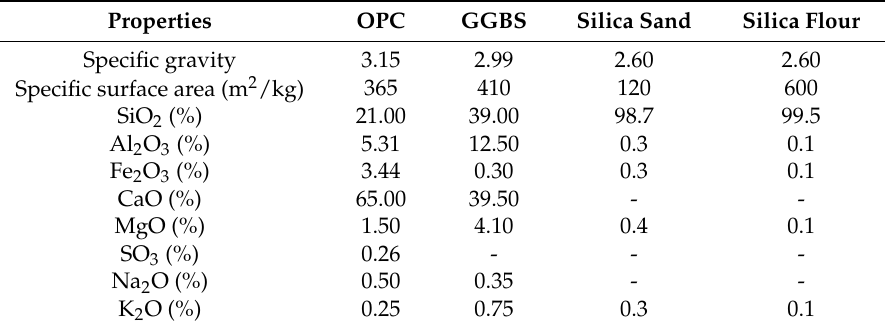
Table 1. Major properties of solid materials used in concrete